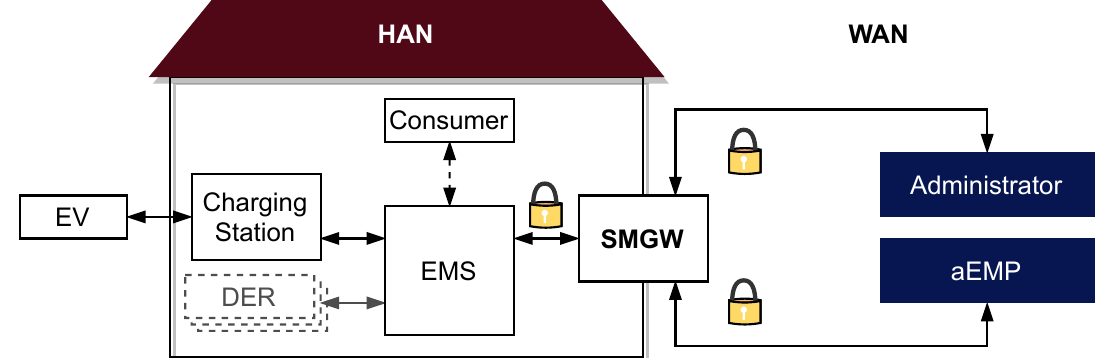
Figure 4. Outline of the implemented prototype: The decentralized energy management system performs an optimization which is (i) motivated by a dynamic electricity tariff and a potential maximum power limit dynamically received from an active external market participant (aEMP) via the SMGW, and (ii) restricted by consumer inputs representing degrees of freedom for the